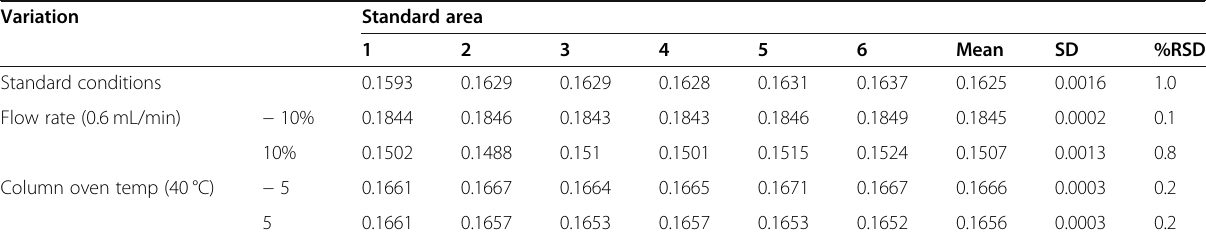
Table 7 Representation of overall statistical data %RSD for ruggedness